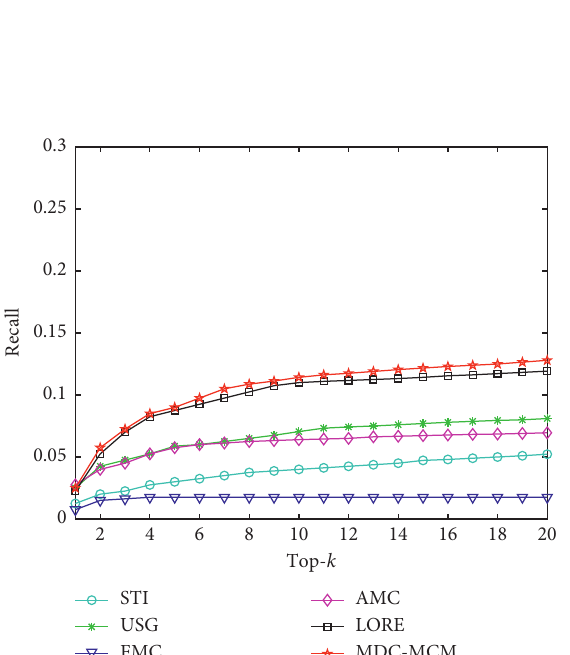
Figure 5: Precision curve.